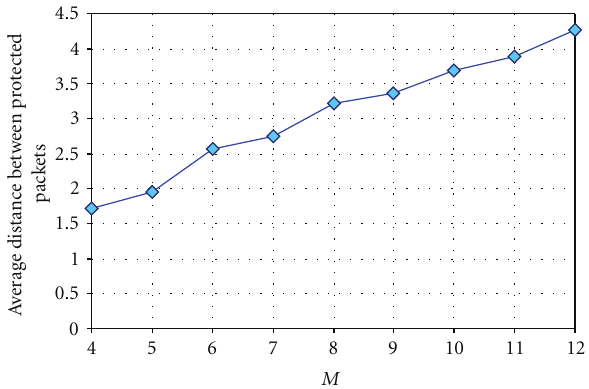
Figure 9: The relationship between global FEC group size, M , and separation distance in the priority-encoded scheme.